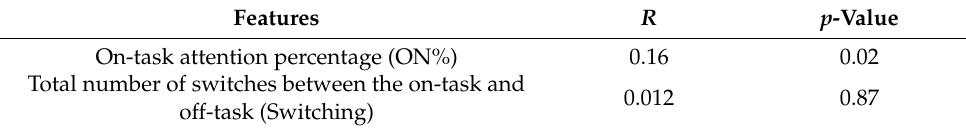
Table 9. Pearson’s Correlation Coefficient ( r ) and p -value between Test 2 and the Attention Features. Features R p -Value On-task attention percentage (ON%) 0.16 0.02 Total number of switches between the on-task and 0.012 off-task (Switching)